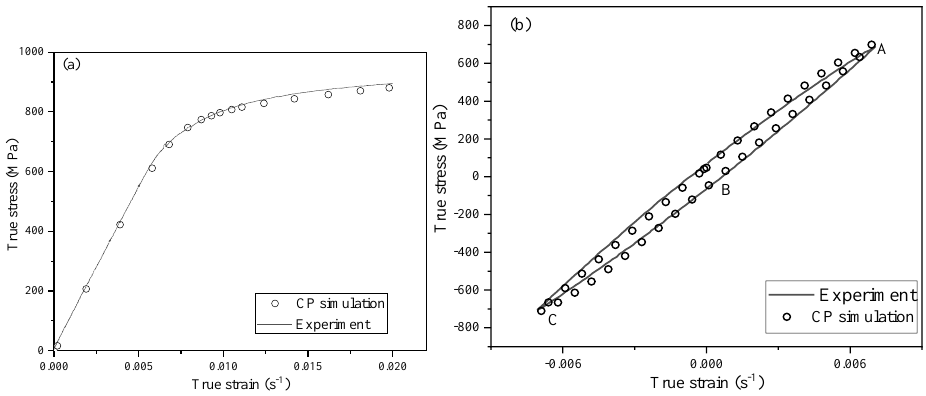
Figure 7. Crystal plasticity simulation and experimental results: ( a ) 2% uniaxial tension; and ( b ) steady-state hysteresis loop at 1.4% cycle deformation.